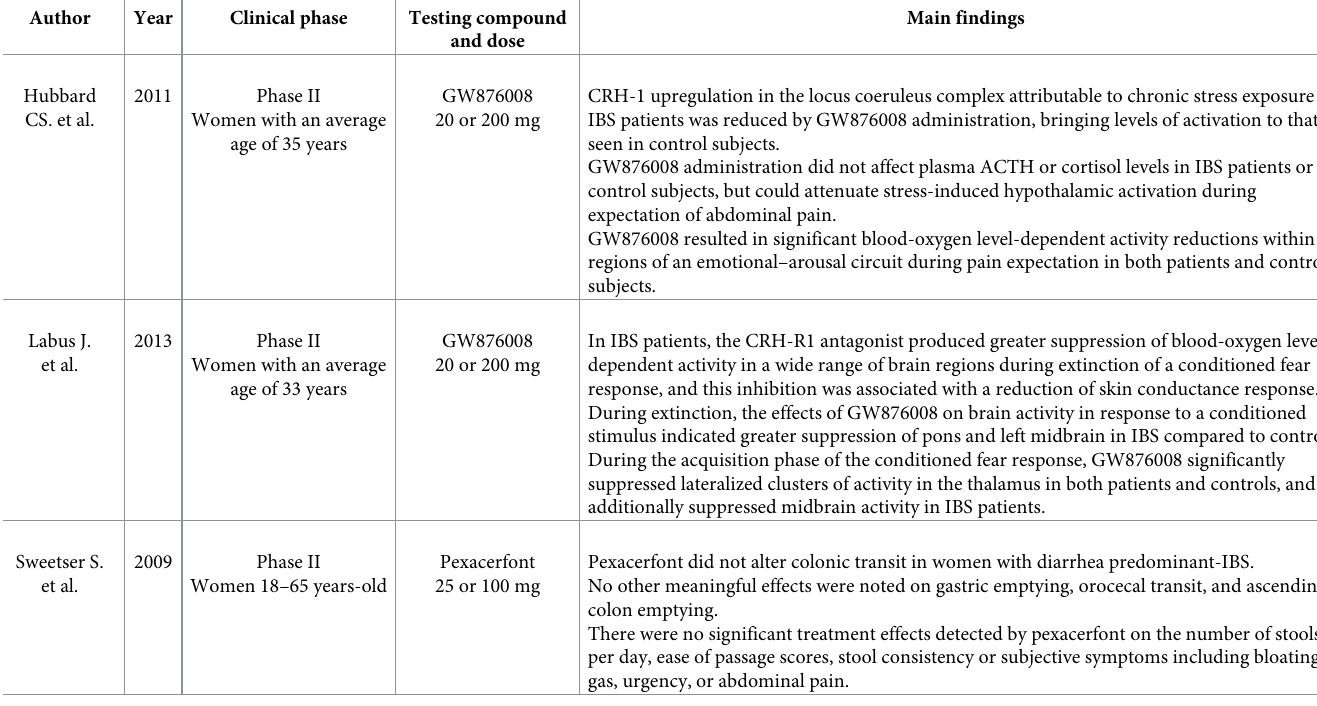
Table 5. Summary of clinical trials using CRH antagonists against disorders of the abdominal or pelvic